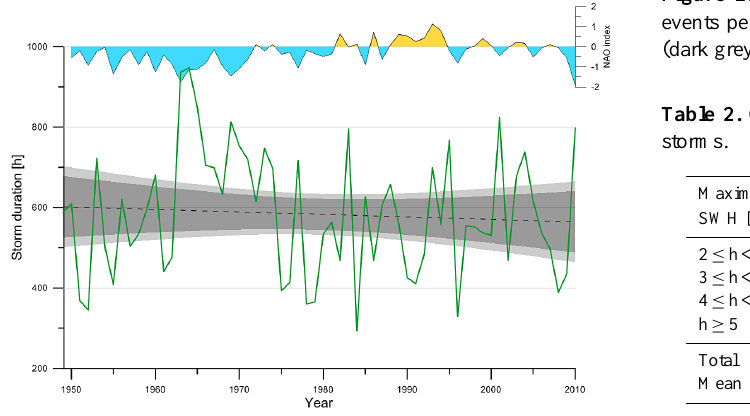
Figure 25. Interannual variability of the NAO index and total storm duration per year, its linear trend ( − 0.62hyear − 1 ), and 95% (dark grey) and 99% (light grey) confidence intervals.